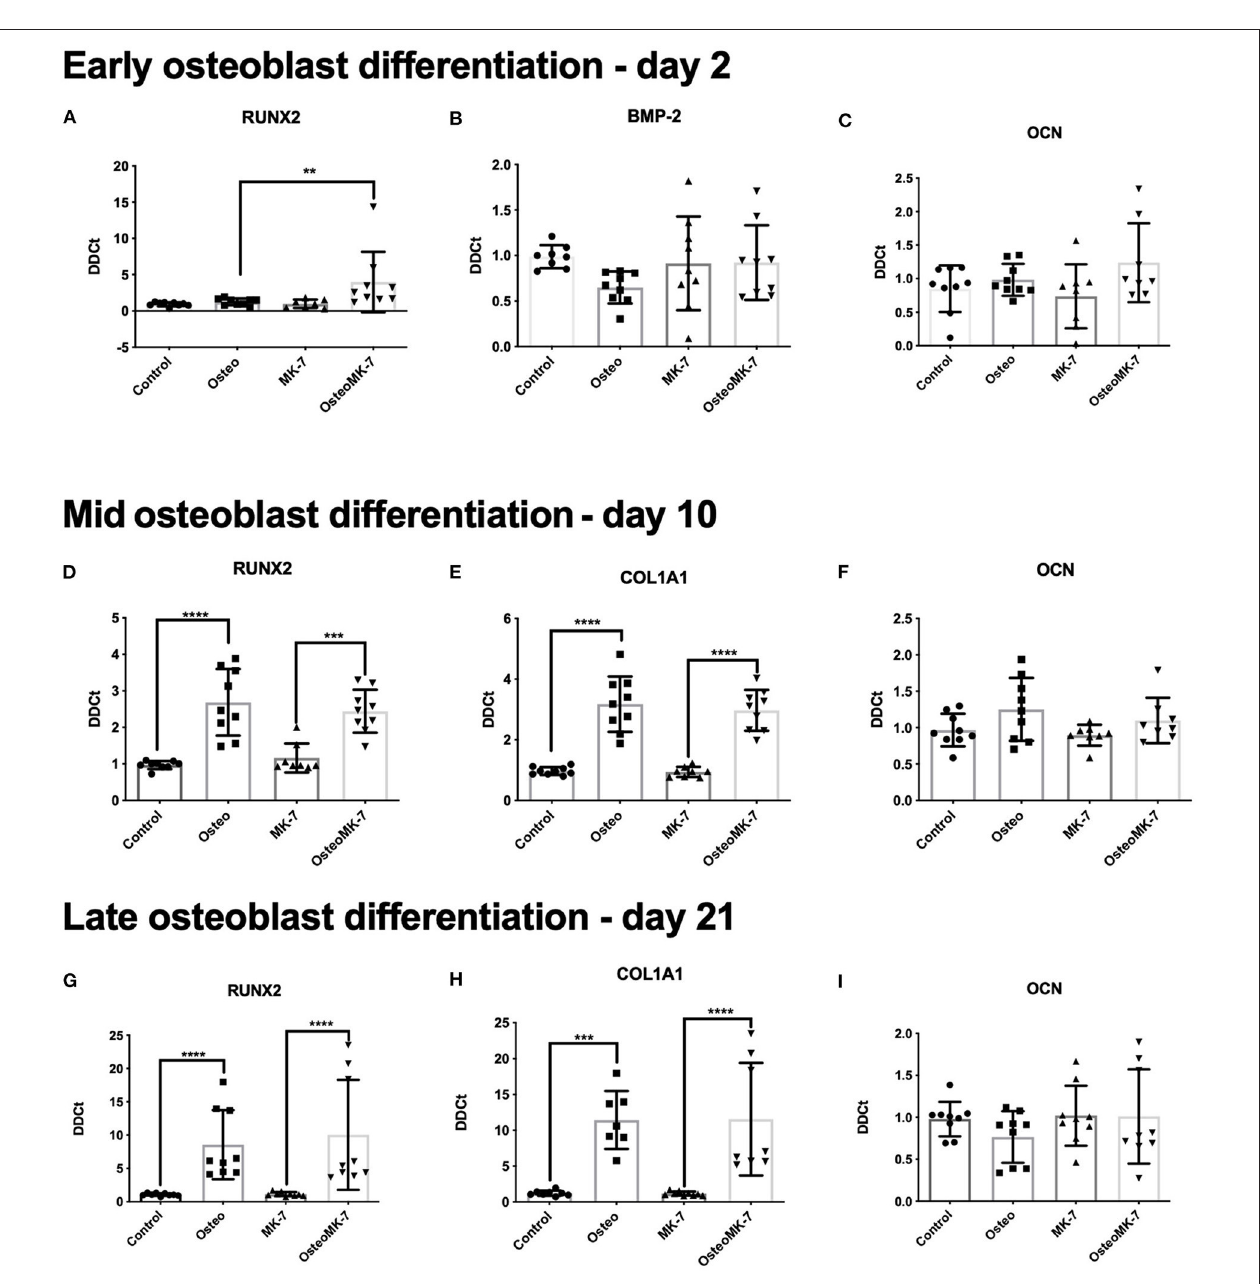
FIGURE 3 | RT-qPCR expression of markers at various time points in differentiation. RT-qPCR of RUNX 2 (A,D,G) at various time points reveals its upregulation from controls as early as timepoint day 2 wherein RUNX2 is significantly upregulated under OsteoMK7 compared to controls and Osteo ( p = 0.0040). At earliest timepoint BMP2 expression was not modulated between any treatments (B) . COL1A1 (E,H) is significantly upregulated in osteogenic differentiation from day 10 ( p < 0.0001). However, osteocalcin (C,F,I) has no differences in expression via any of the treatment over any time point in the differentiation. ** p < 0.01, *** p < 0.001, **** p <